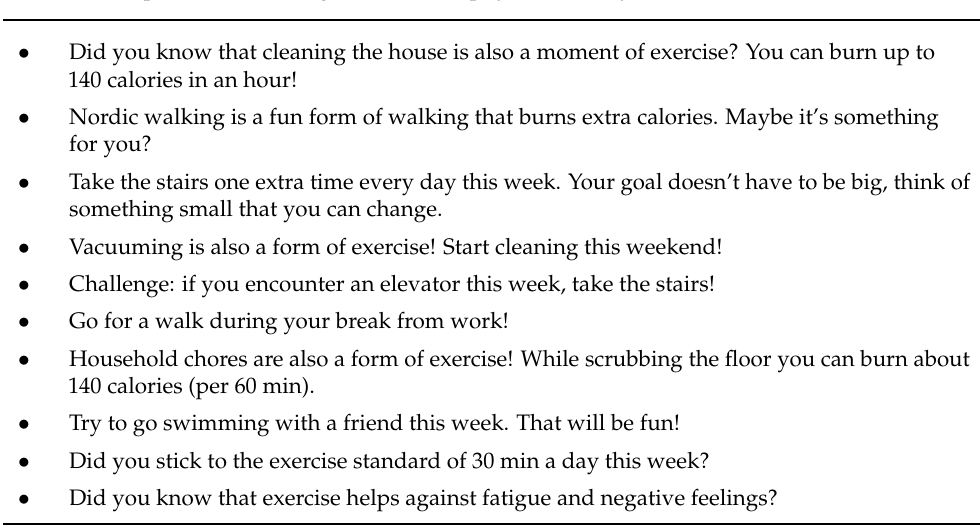
Table 1. Examples of text messages focused on physical